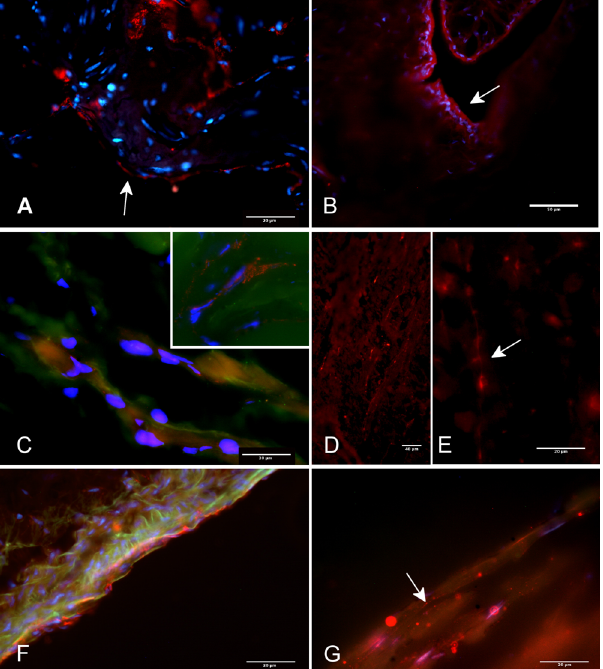
Fig 8. Fluorescence microscopy of tirosinehydroxylaseantibody(TH Ab, red) labelledin hemipenis from Crotallusdurissus terrificus ( A) and in neurofilaments (green)from corpora cavernosaof Callithrix jachus ( C ). B : Endotheliallayer of hemipenis from Crotallusdurissus terrificus labelledwith TH antibody. D and E . Brain of Crotallusdurissus terrificus labelledwith TH. F . Trunk regionof hemipenis from Crotalus durissus terrificus showingTH (red) and neurofilaments(green) G . Apical regionof hemipenisof Crotalus . durissus . terrificus labelledwith TH Ab.